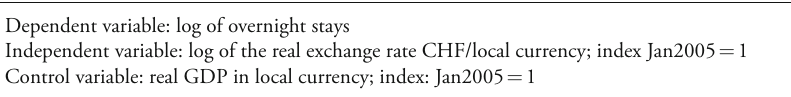
Table 2: Country Group